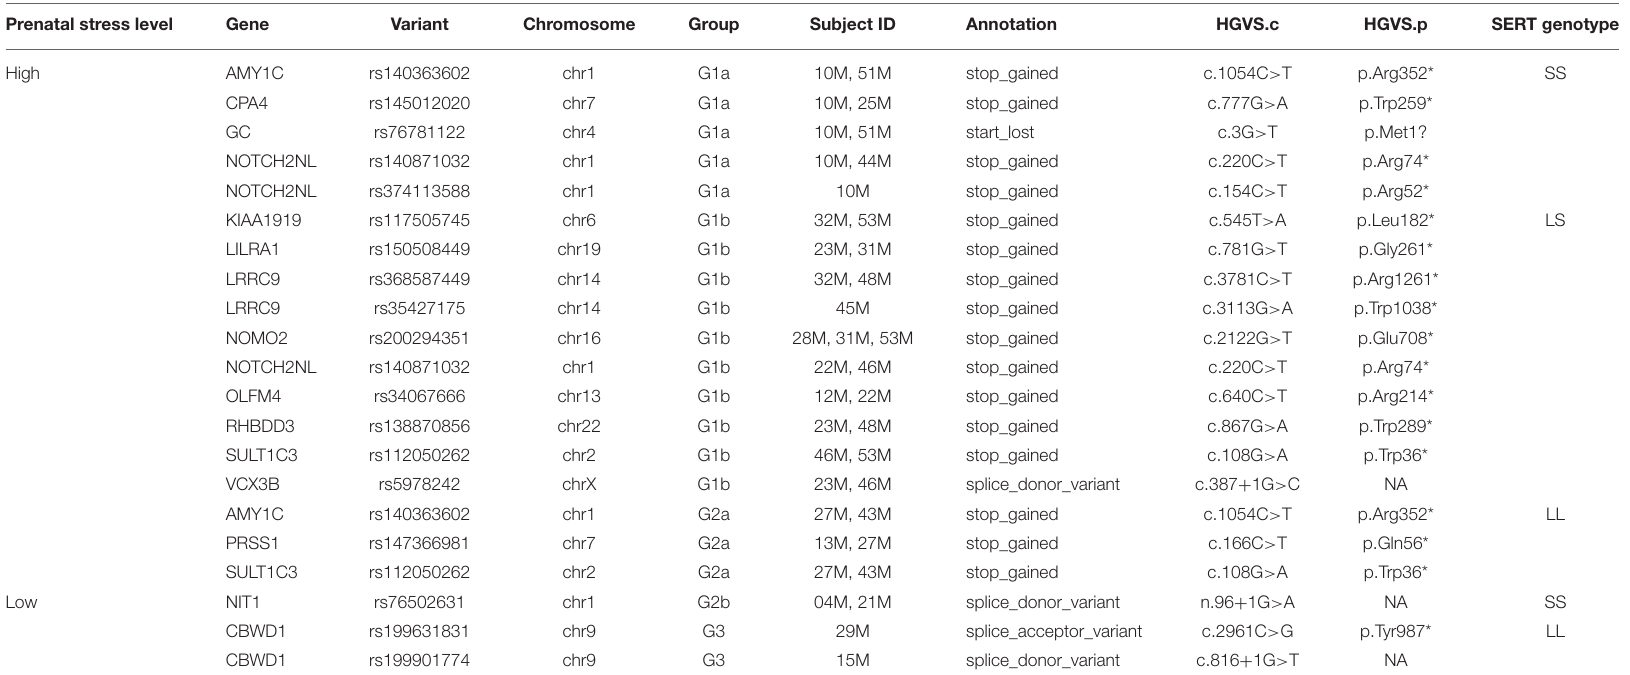
TABLE 4 | High-impact recurrent SNVs identified in each